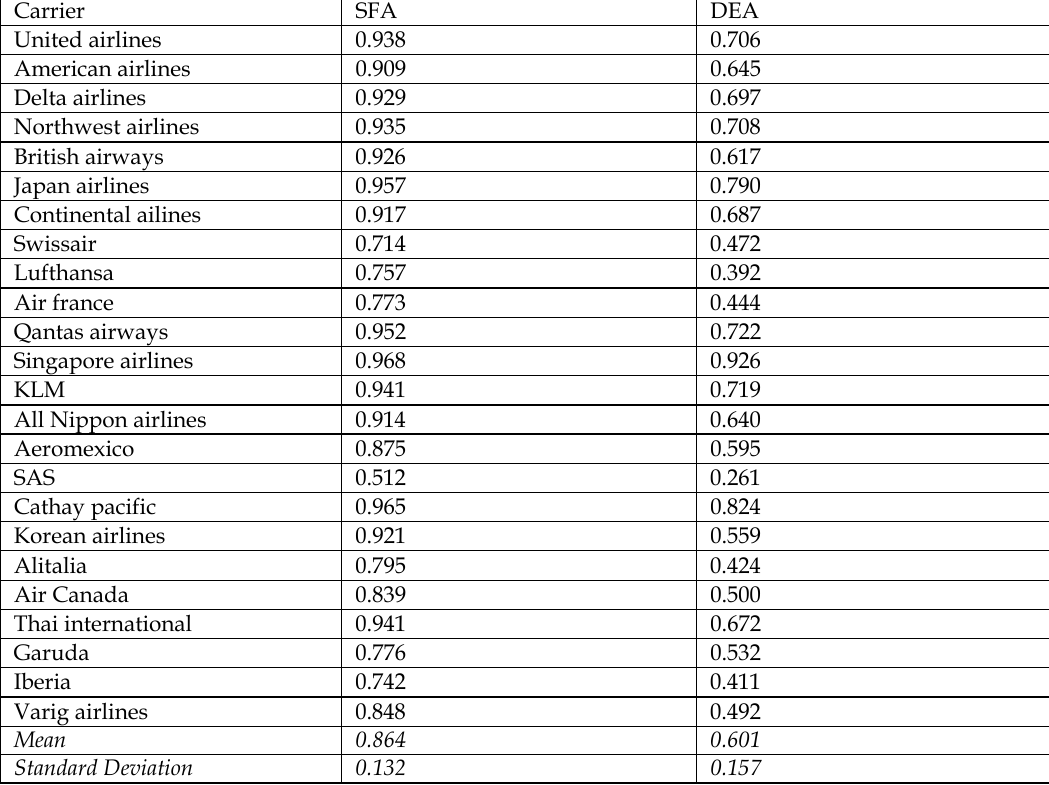
Table 2. Results of efficiency